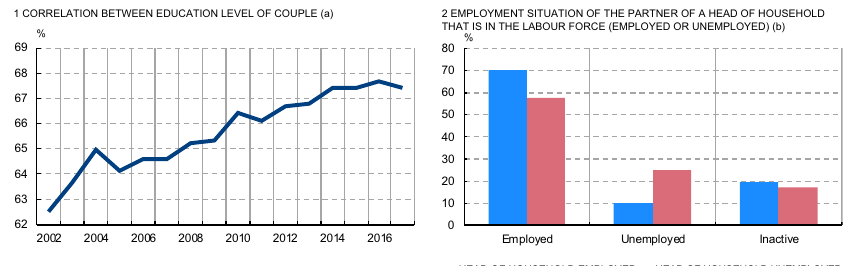
Fig. 3 Assortative mating indicators. a. On EPA data for Q2 of each year. The values are obtained from a regression of the wife’s education level on that of her partner, dummy variables for the year and interaction termsbetweenthepartner’seducationlevelanddummyvariablesfortheyear,withthecoefficientsestimated from the interaction terms. b. On EPA data for 2017 Q2. Sources : INE (EPA) and Banco de España Table 3 Inequality indicators for various variables (2014). Source : Banco de España (EFF) Individual earned Household earned Gross per capita Gross total income (a) income (a) income household